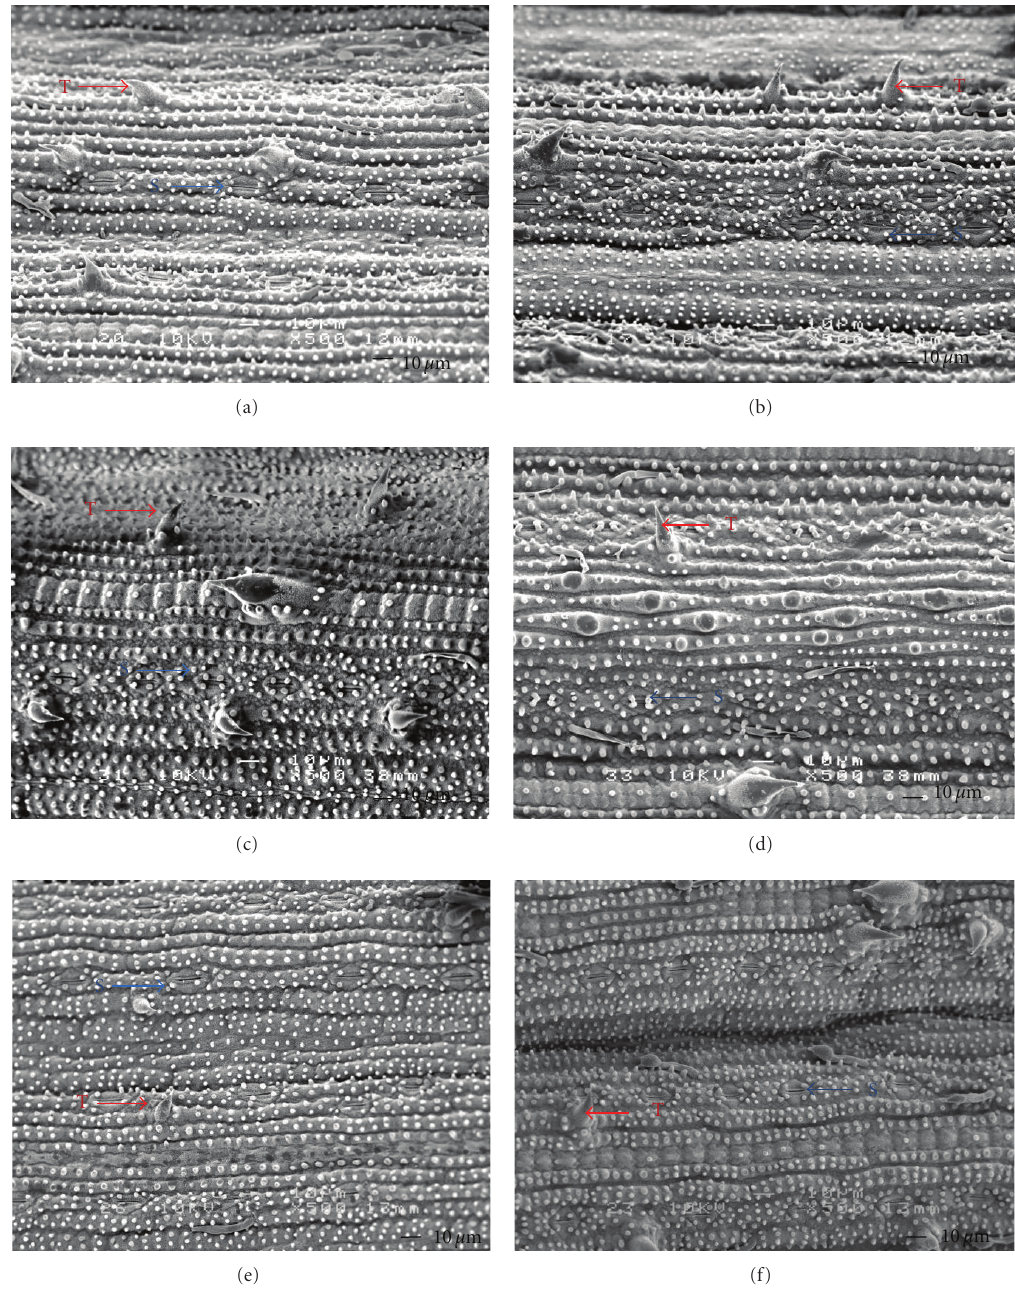
Figure 2: Scanning electron micrograph showing adaxial (a) and abaxial (b) surfaces of in vitro leaf of plantlet from synthetic seed of Oryza sativa L. Cv. MRQ 74, adaxial (c) and abaxial (d) surfaces of leaf from in vivo (intact) plant, adaxial (e), and abaxial (f) surfaces of in vitro leaf of plantlet from culture medium containing 0.1 mg/L BAP and 0.1 mg/L NAA. S: stomata, T: trichomes.